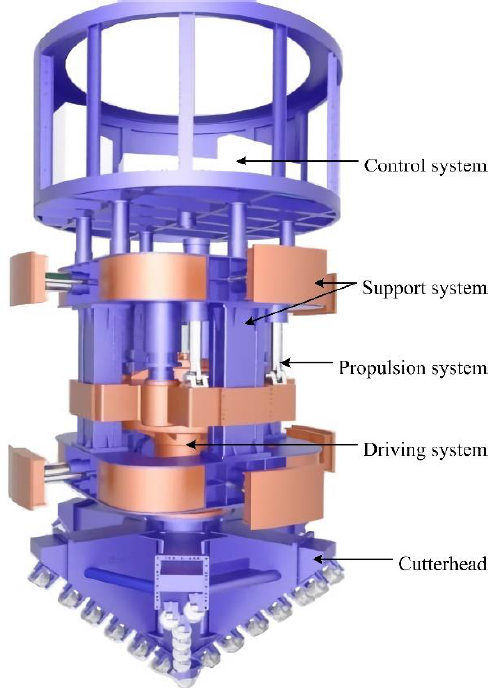
Figure 1. Overall structure of the shaft boring machine ( SBM).